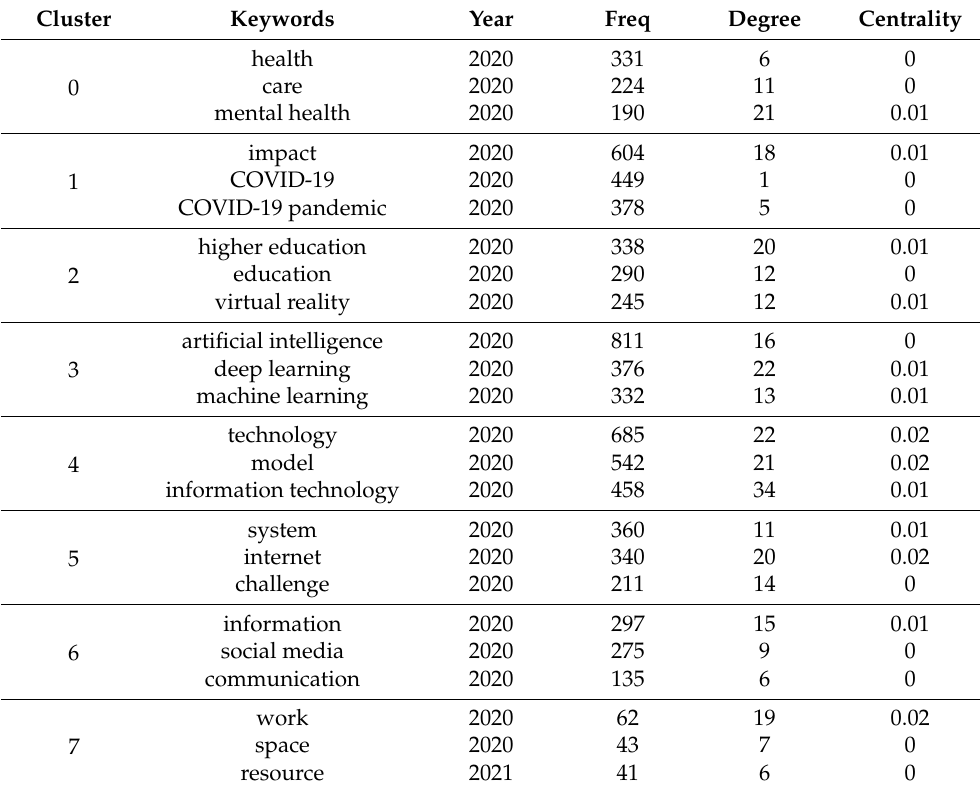
Table 7. Representative keywords from keyword co-occurrence